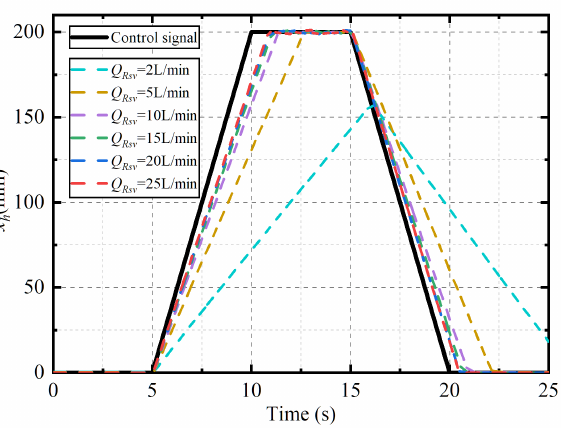
Figure 17. Displacement output, x h , at different rated flows of servo valve, Q Rsv , when depth is 11 km. f. Cracking pressure of relief valve.